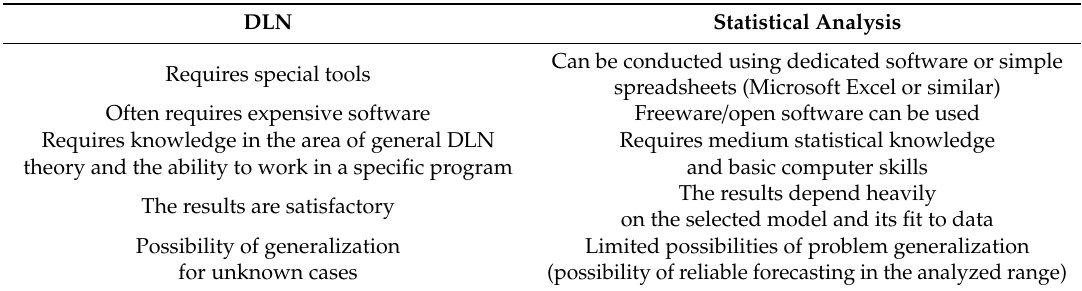
Table 9. Comparison of deep learning networks and statistical analysis advantages and